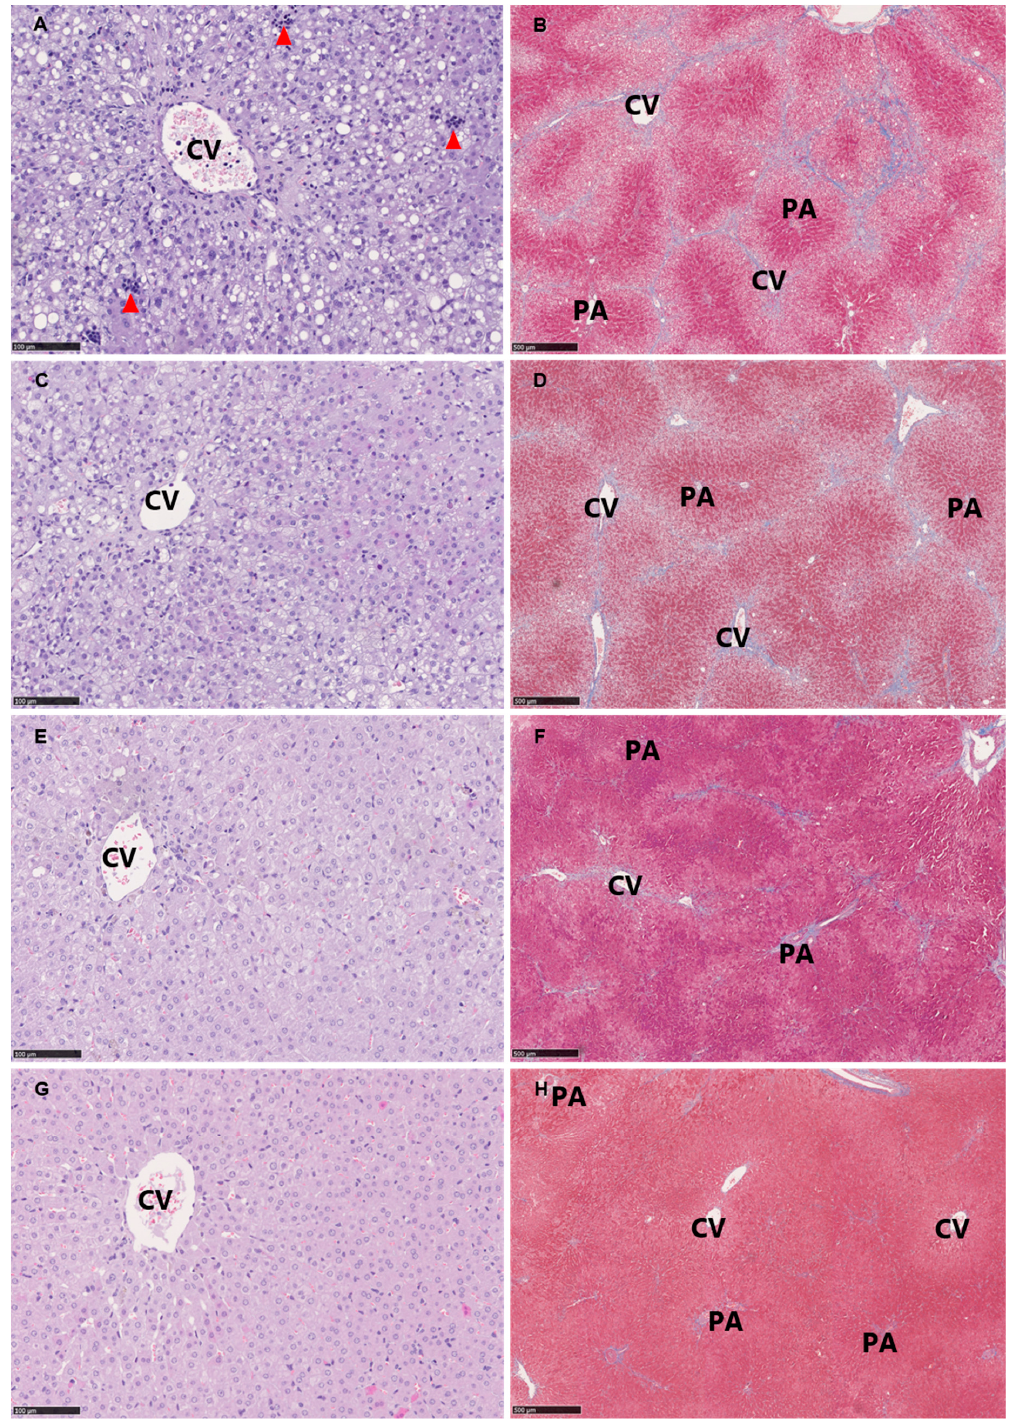
Figure 3. Representative histological images at study termination (Week 28) of hepatic tissue from: HF ( A , B ); HF + ( C , D ); LF ( E , F ); and LF + ( G , H ). ( A , C , E , G ) Hematoxylin and eosin stain, scale bar 100 µ m. ( B,D,F,H ) Masson’s trichrome stain (fibrosis stained blue), scale bar 500 µ m. Classical pathological lesions of NASH include: steatosis distributed as macro and micro vesicular steatosis, lobular inflammation as inflammatory clusters (red arrowheads) and ballooning hepatocytes (not clearly identified in the current magnification). Advanced and bridging fibrosis is seen in ( B,D ) (fibrosis in blue). CV, central vein; PA, portal